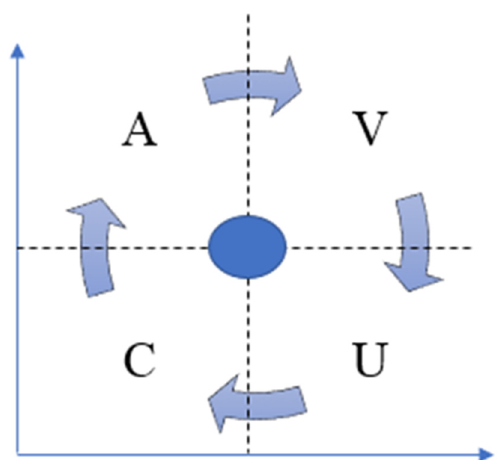
Figure 1. Mutual interaction of VUCA components.